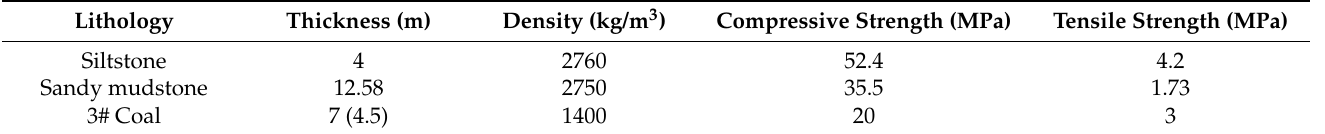
Table 1. Thickness and mechanical parameters of different strata.